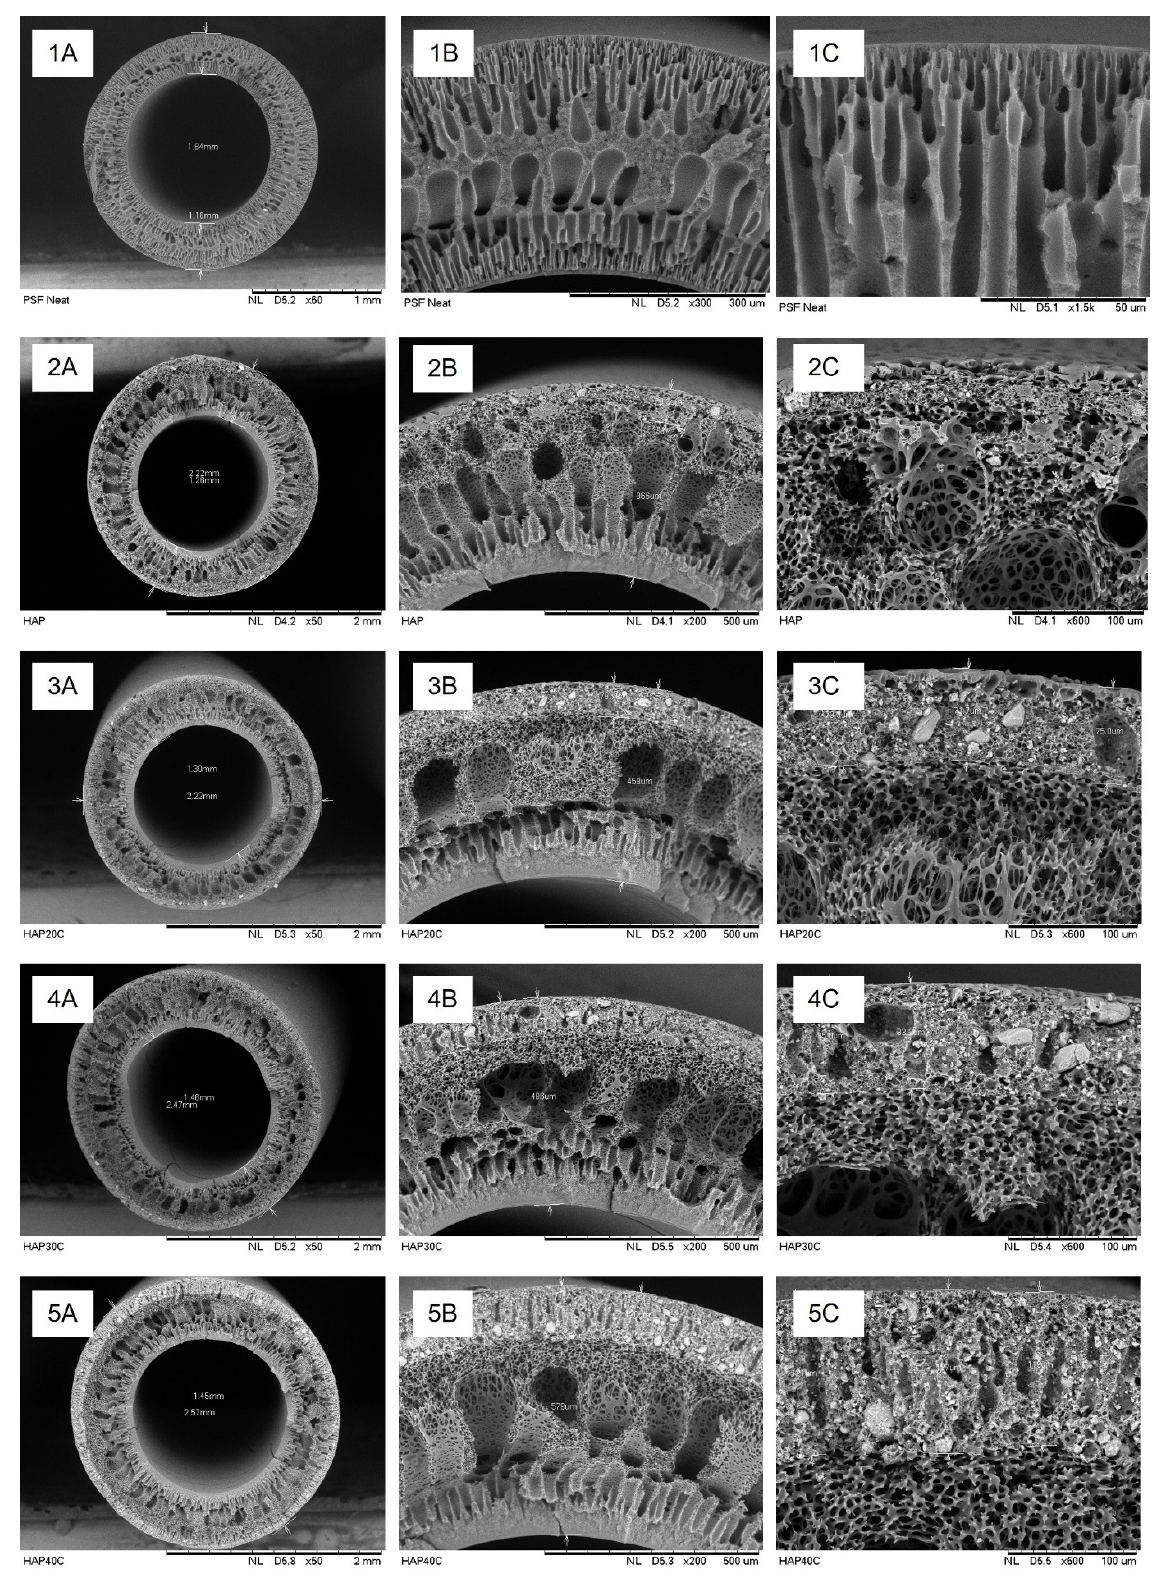
Figure 6. Cross ‐ sectional SEM images of ( 1 ) M0, ( 2 ) M10, ( 3 ) M20, ( 4 ) M30, and ( 5 ) M40 at ( A ) 50×, ( B ) 200×, and ( C ) 600× magnification.